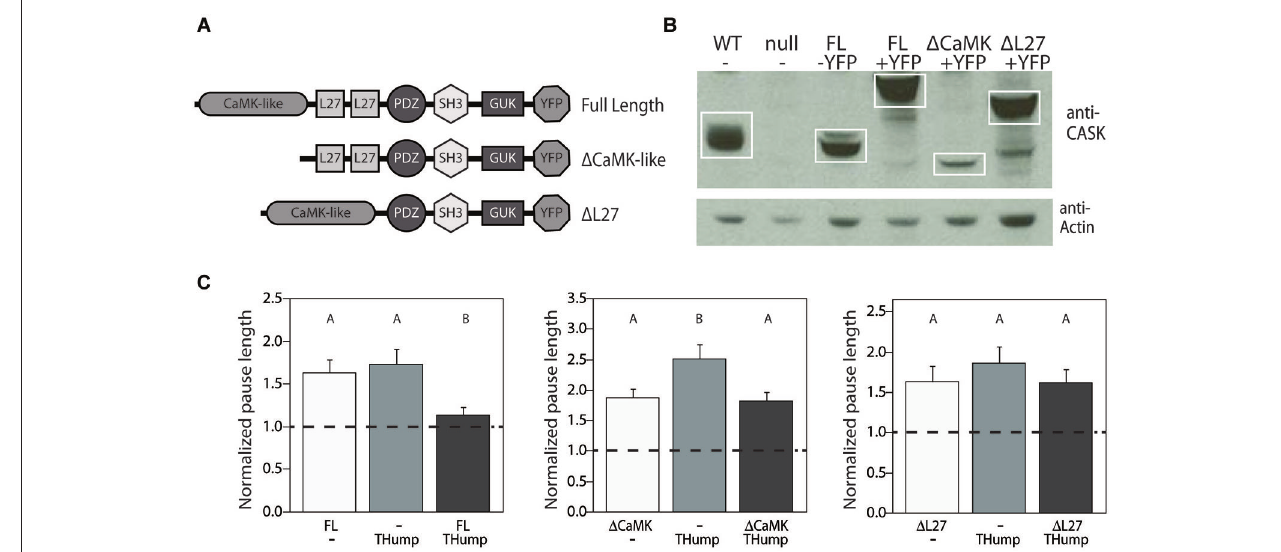
all groups are normalized to WT control levels which are shown as a dotted black line at 1.0 on the Y-axis of each graph. The magnitude of the deviation from the dotted line is proportional to severity of phenotype. Transgenes present in each group of animals are indicated below the histogram bars: “FL” = Full Length CASK- β , “ ∆ CaMK” = CaMK-like domain-ablated CASK- β , and “ ∆ L27” = L27 domain-ablated CASK- β . All transgenes were on a CASK - β mutant background, and letters indicate significant differences between groups ( P < 0.05, ANOVA with Tukey HSD). See Section Methods for details on statistical